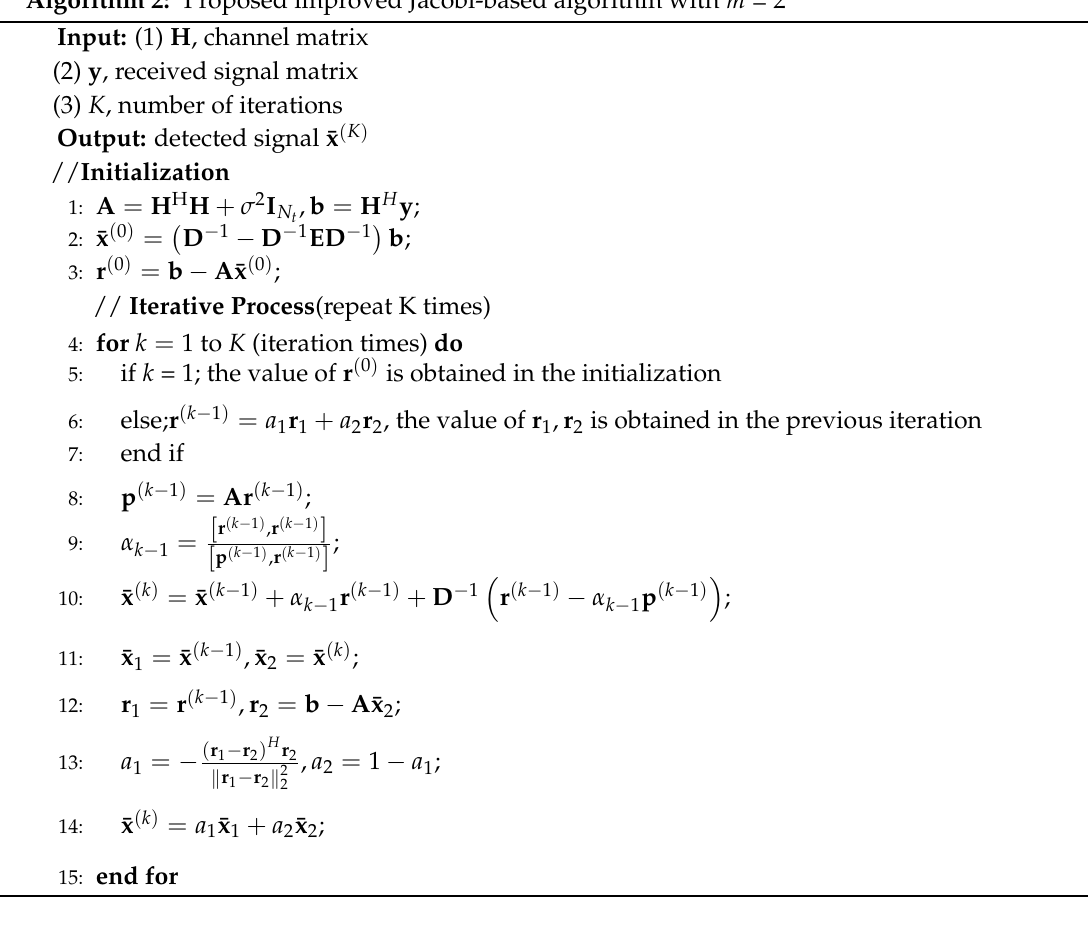
Algorithm 2: Proposed improved Jacobi-based algorithm with m =